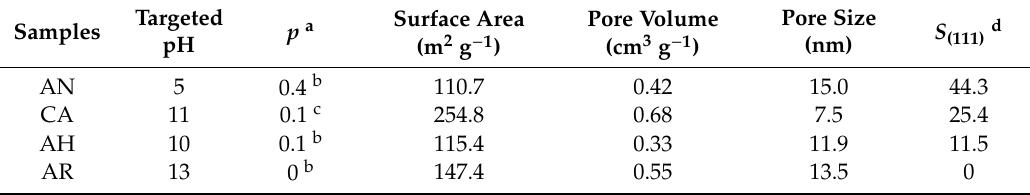
Figure 1. TEM images of the γ -alumina samples ( a , b ) CA; ( c , d ) AN; ( e , f ) AH; ( g , h ) AR. Table 1. Texture properties and (111) facet portions of the alumina samples. Table 1. Texture properties and (111) facet portions of the alumina samples.